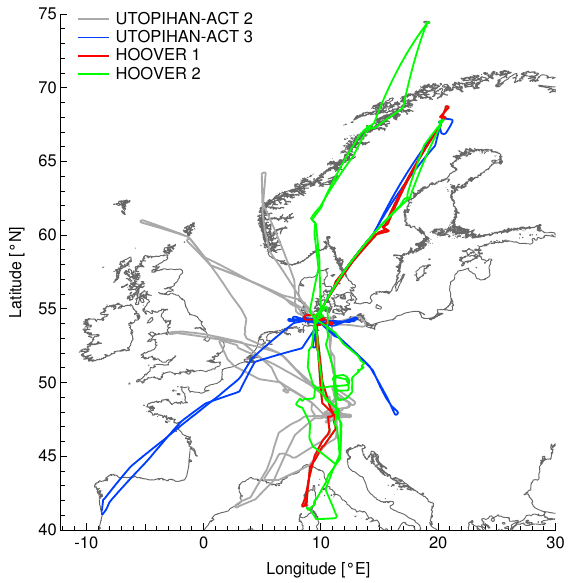
Fig. 1. Flight tracks of the measurement campaigns UTOPIHAN-ACT 2 (July 2003), UTOPIHAN-ACT 3 (March 2004), HOOVER 1 (October 2006) and HOOVER 2 (July 2007) over Europe.